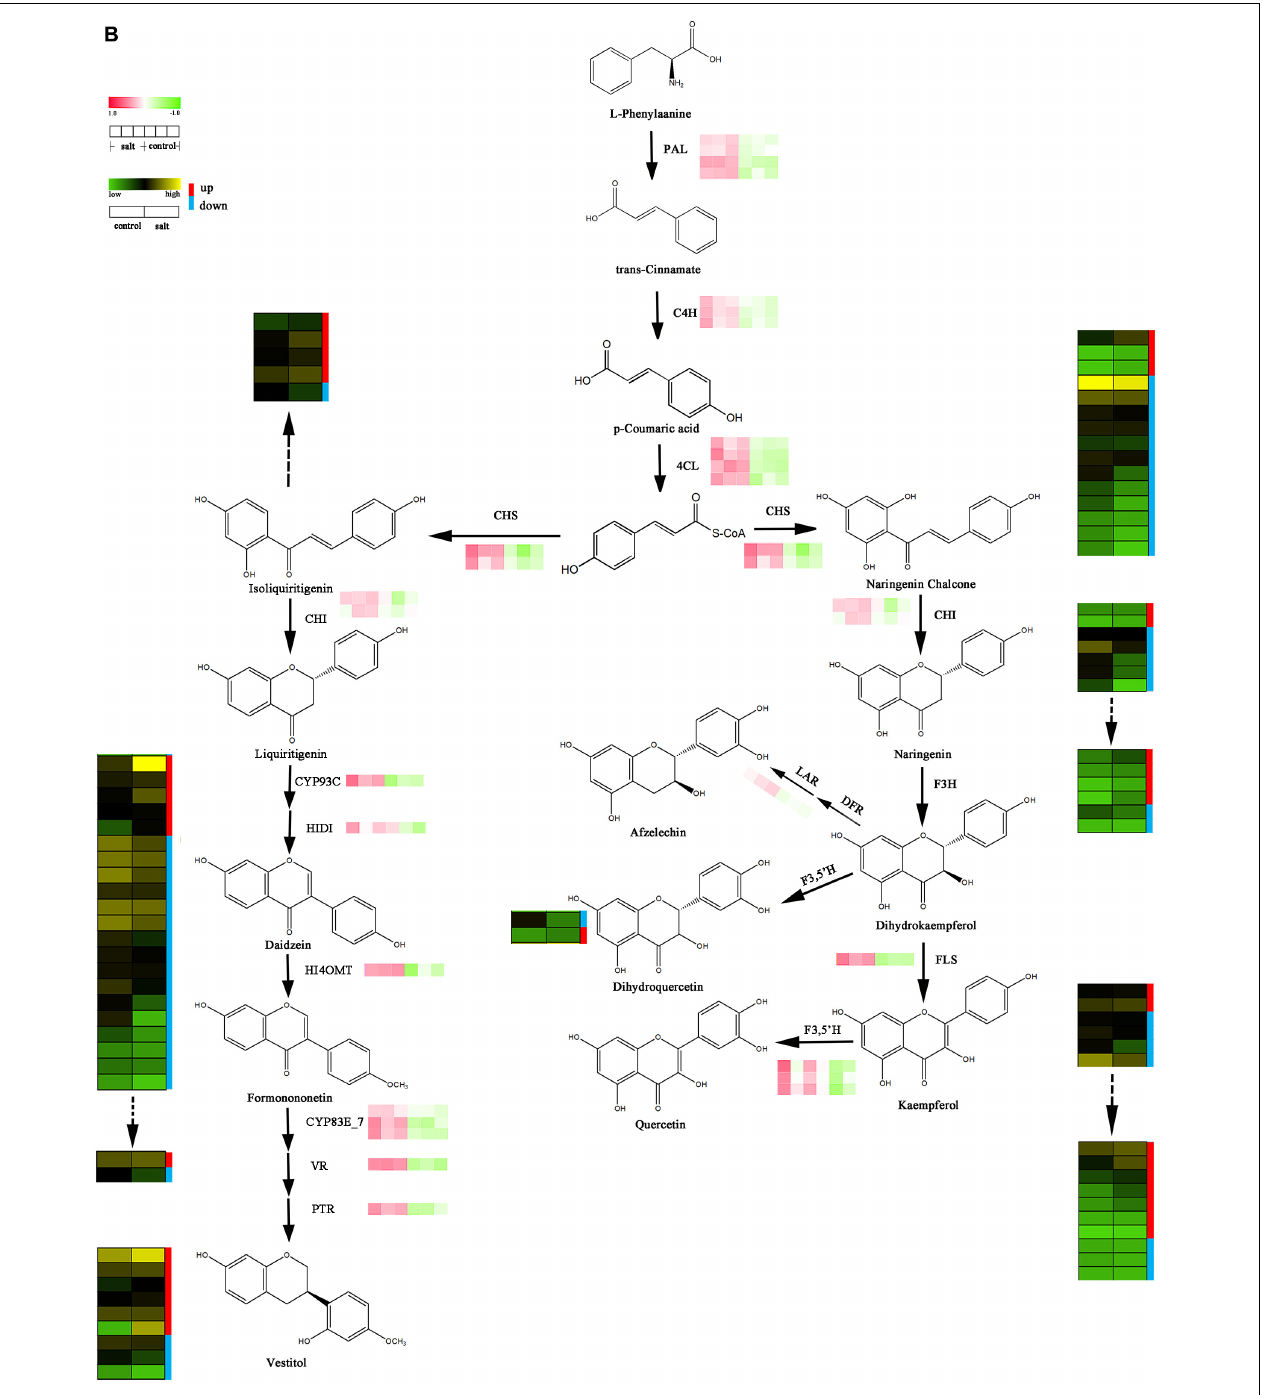
FIGURE 4 | (A) Expression levels of structural differentially expressed genes (DEGs) involved in flavonoid biosynthesis. (B) Correlation analysis of expression pattern of key DEGs and metabolite profiles of flavonoids in licorice.